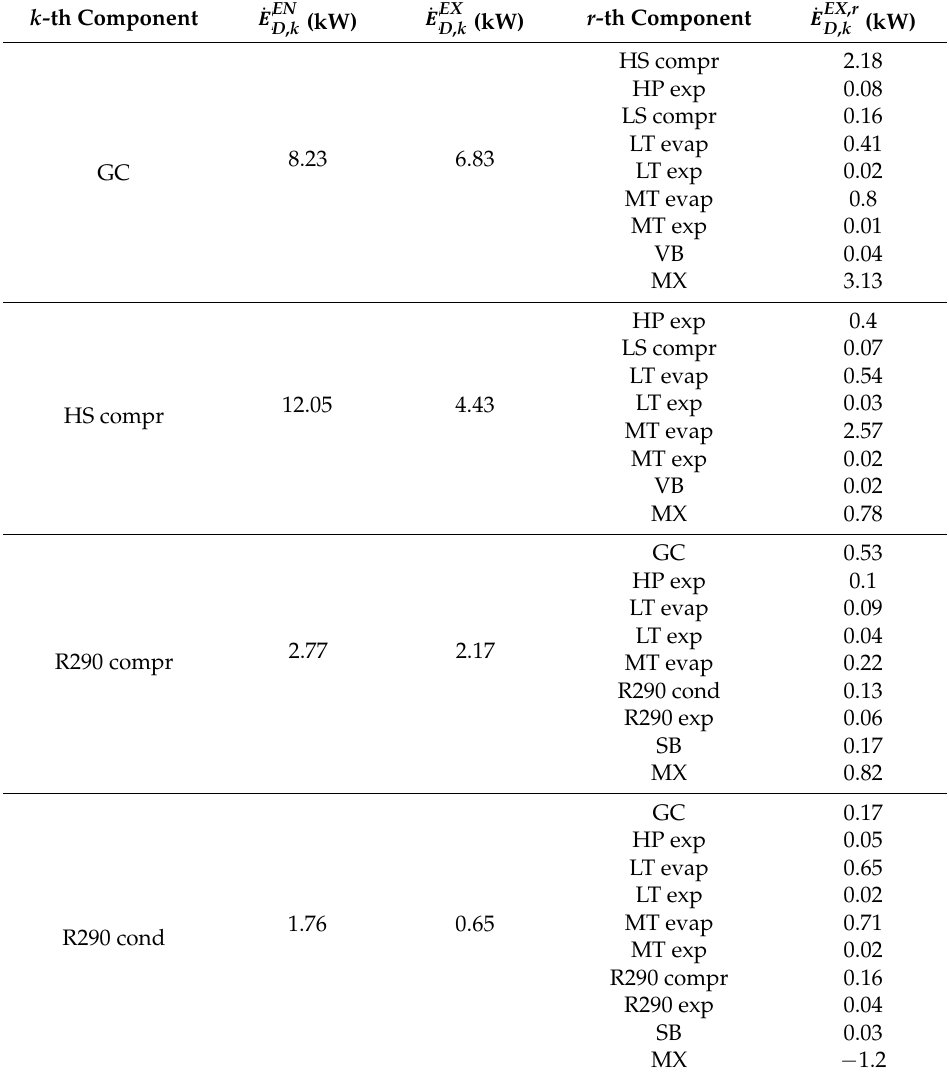
Figure 4. Breakdown of the contribution (%) of each component belonging to DMS to the total exergy destruction rate at the outdoor temperature of 40 °C. Table 9. Mexogenous exergy destruction rates of the components belonging to DMS at the outdoor temperature of 40 ◦ C. Table 8. Results related to the advanced exergy analysis for DMS at the outdoor temperature of 40 °C.